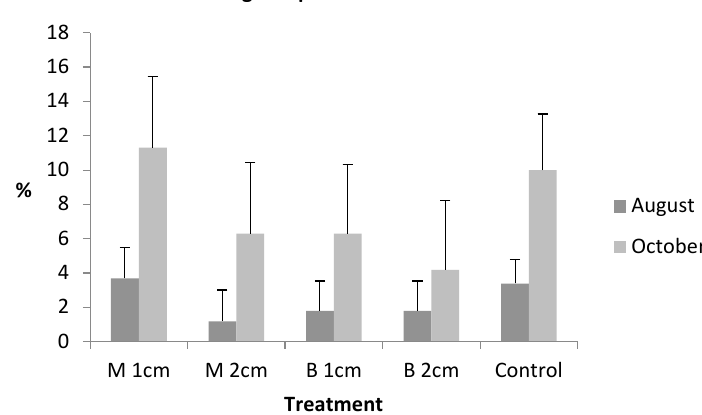
Fig. 3. Mean values and SE of liverwort invation % on pot surface of blackcurrant plants with different Sphagnum mulches in 2018. Treatment n=30